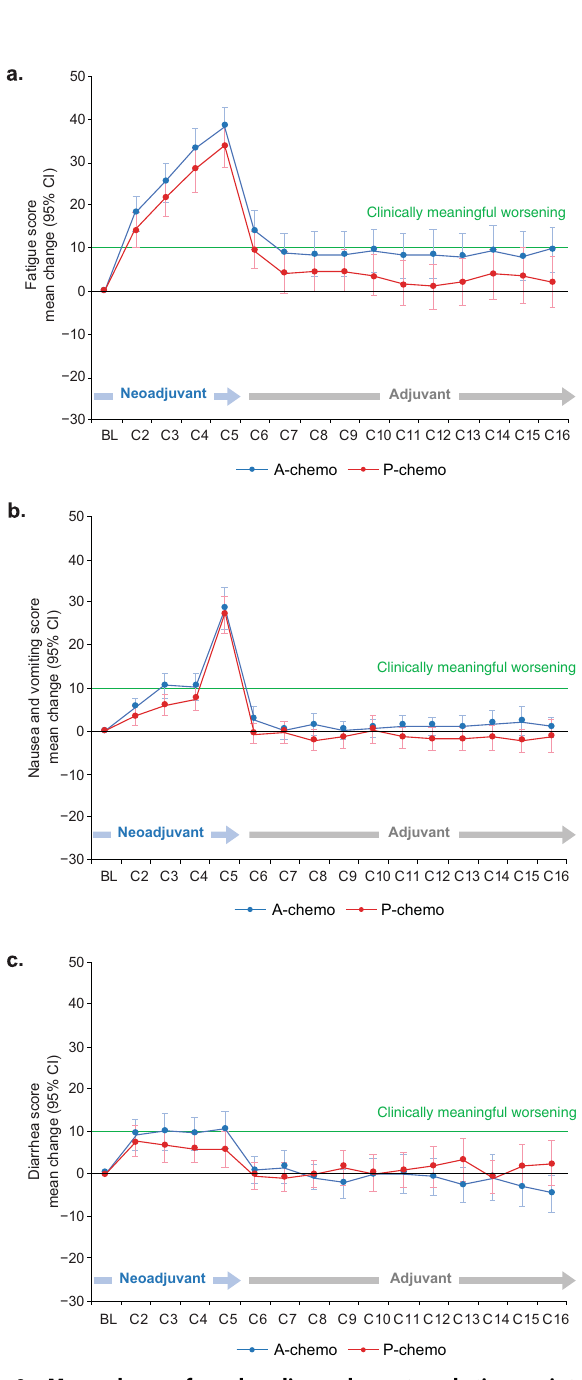
Fig. 3 Mean change from baseline values at each time point in fatigue, nausea and vomiting, and diarrhea. Error bars indicate 95% con fi dence intervals. Mean change from baseline values at each time point in a fatigue, b nausea and vomiting, and c diarrhea was measured using the EORTC QLQ-C30. A atezolizumab, BL baseline, C cycle, P